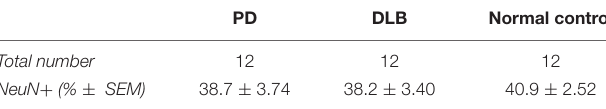
TABLE 2 | FANS neuronal and glia nuclei. PD DLB Normal